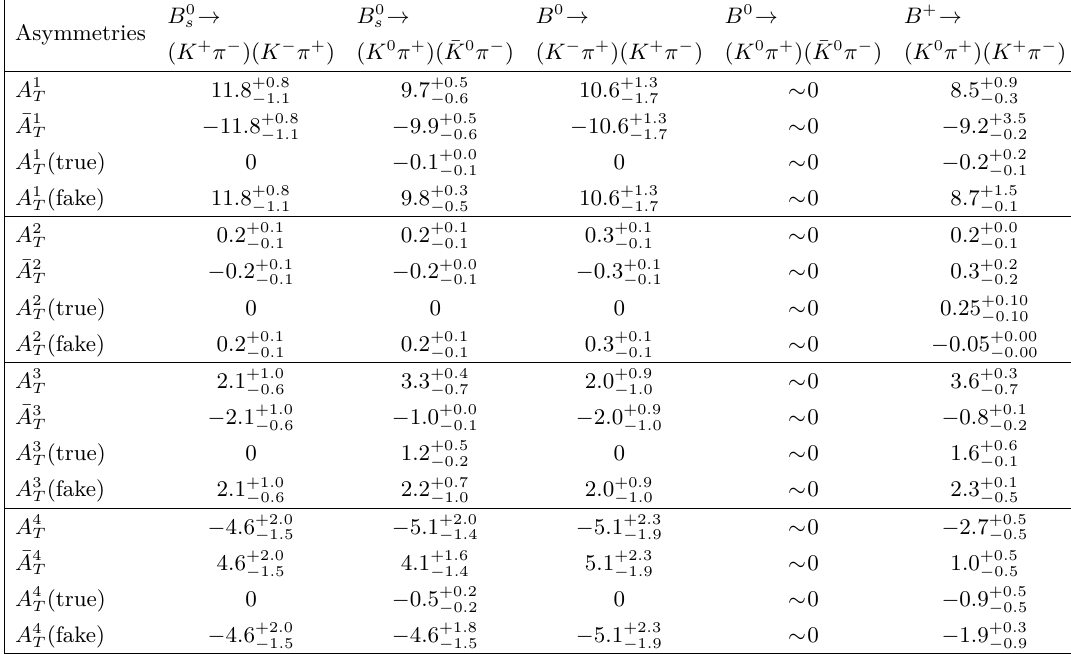
Table 4 . PQCD predictions for the TPAs ( % ) of the considered decays in the Kπ invariant mass window of 150 MeV around the K ∗ (892) resonance. The sources of theoretical errors are the same as in previous tables but added in